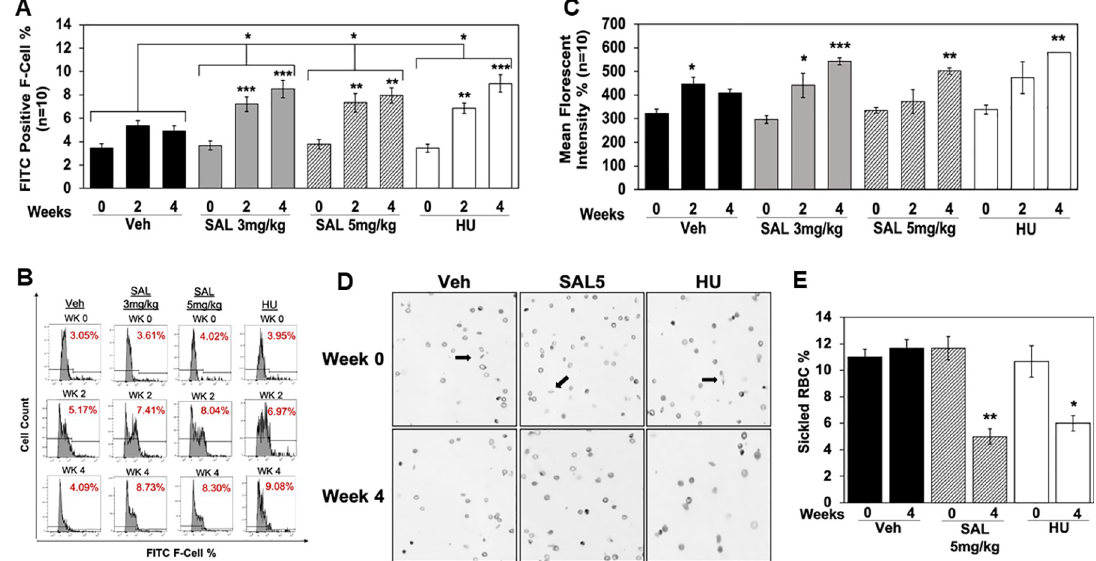
Fig 6. SAL increases HbF expression and produce anti-sickling effects in SCD mice. A) Peripheral blood collected at the time points shown was stained with FITC-anti-HbF antibody and flow cytometry performed to quantify F-cells by FlowJo analysis. The paired student’s t-tests were used to determine the significance in F-cells at week 0 compared to week 2 and 4 within each group (n = 10). ANOVA was used to compare the significance of F-cells between water compared to the two concentrations of SAL and HU group; results are represented by brackets between treatment group. Data are shown as the mean ± SEM and � p < 0.05; �� p < 0.01; ��� p < 0.001 was considered significant. B) Representative histograms demonstrating the increase in the number of FITC-HbF positive cells from week 0 to week 4 for each treatment group. C) The level of HbF expression per cell was measured by MFI data generated by flow cytometry analysis. D) Shown is a representative image of peripheral blood generated at 40-x magnification by light microscopy. E) The levels of sickled red blood cells for the different conditions (black arrows) were quantified for 500 cells in triplicate and shown in the